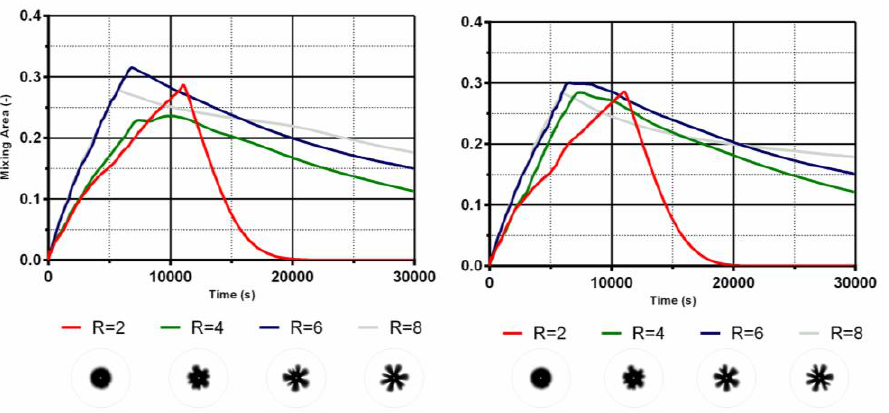
Figure 8. Mixing area plots for different viscosity ratios at velocity Re = 2.2 × 10 − 5 and Pe = 1.45 × 10 − 2 for Darcy’s model ( left ) and modified Darcy’s model ( right ).